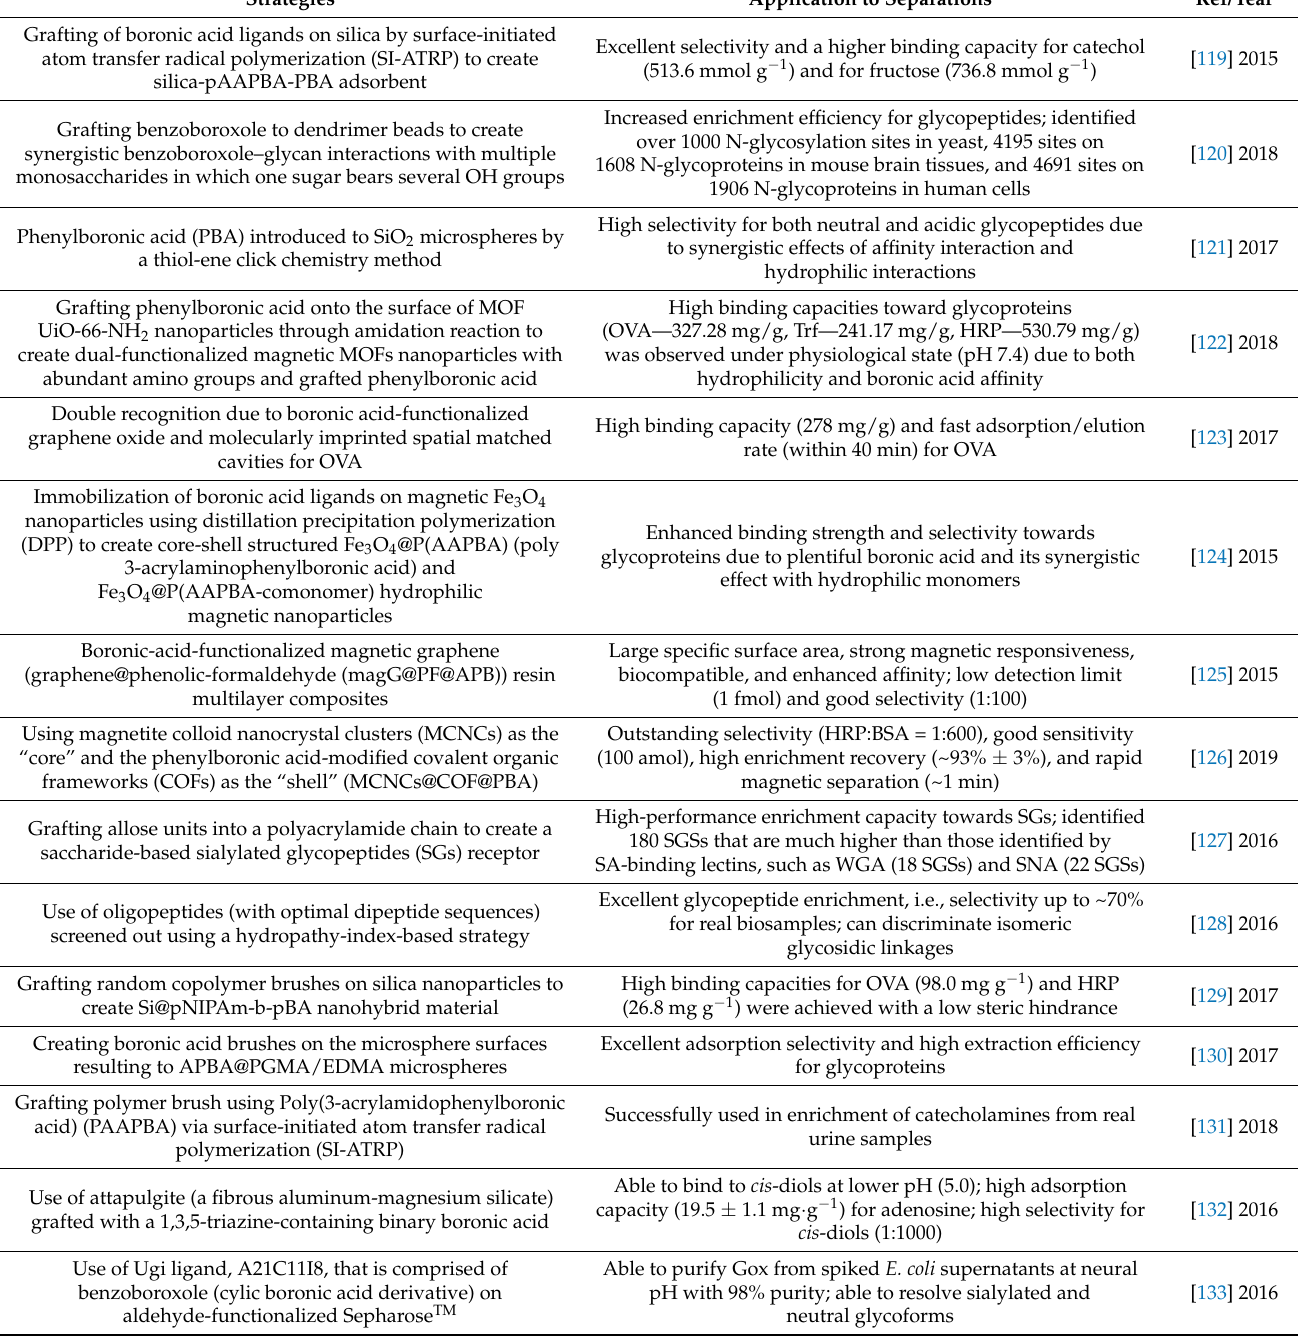
Table 2. Additional strategies in separation and enrichment of glycans and other cis -diol